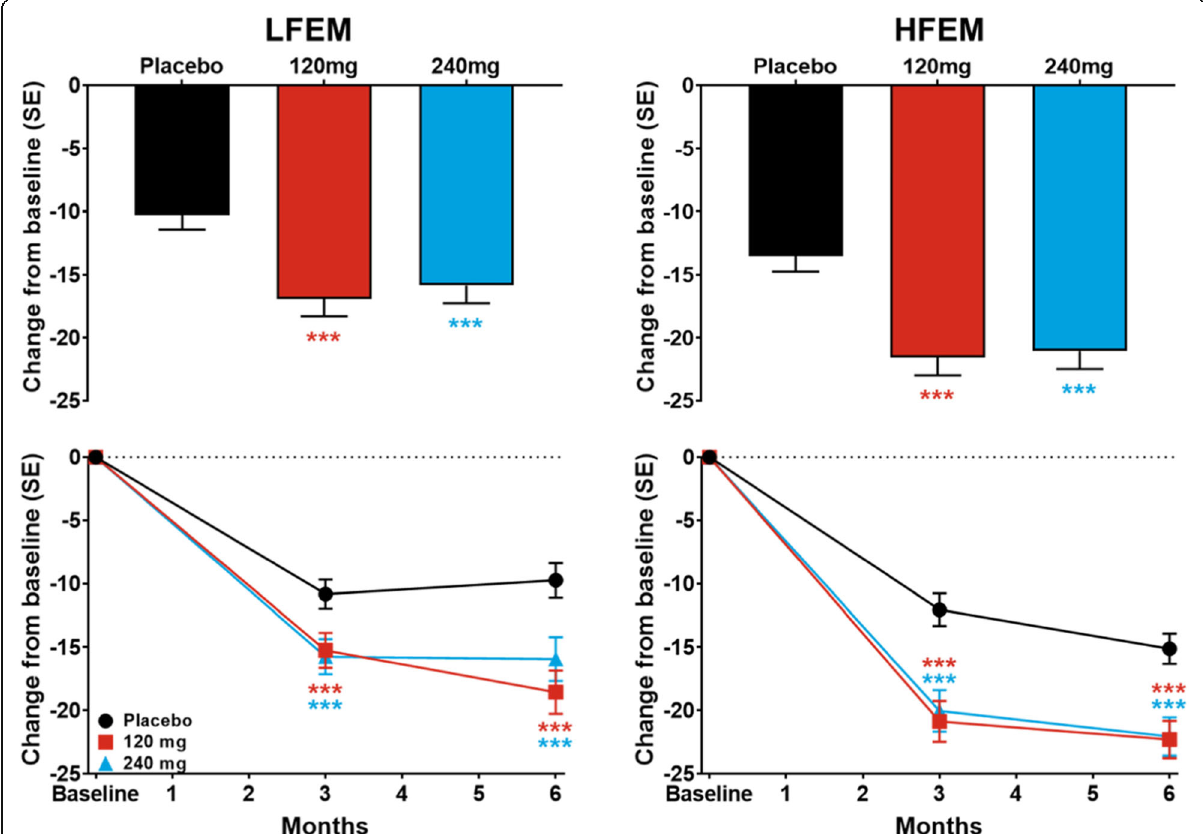
Fig. 7 The overall least-squares (LS) mean change in Migraine Disability Assessment (MIDAS) total Score for the average of Months 3 and 6 is shown for patients with LFEM and HFEM receiving placebo, 120-mg, or 240-mg of galcanezumab in the upper row. The LS mean changes in MIDAS total score at Months 3 and 6 for patients receiving these treatments is shown in the bottom row for patients with LFEM and with HFEM. *** p ≤ .001, ** p ≤ .01, * p ≤ .05 vs